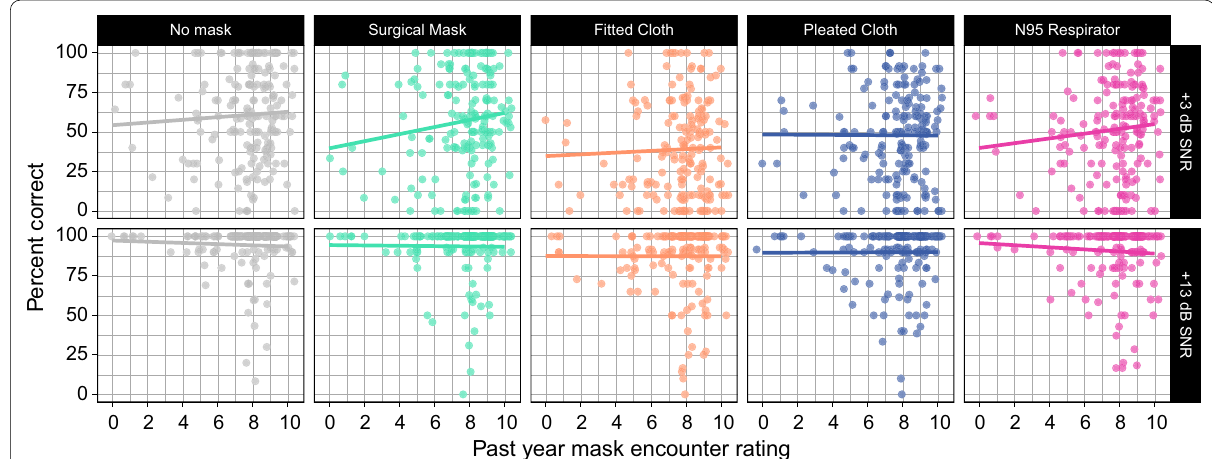
Fig. 3 Average performance by mask type and SNR as a function of self-reported frequency of encounters with masked individuals in the past year. Trend lines represent simple linear regressions. Although there is a positive trend at the low SNR for the surgical mask and N95 respirator, these effects were not statistically significant